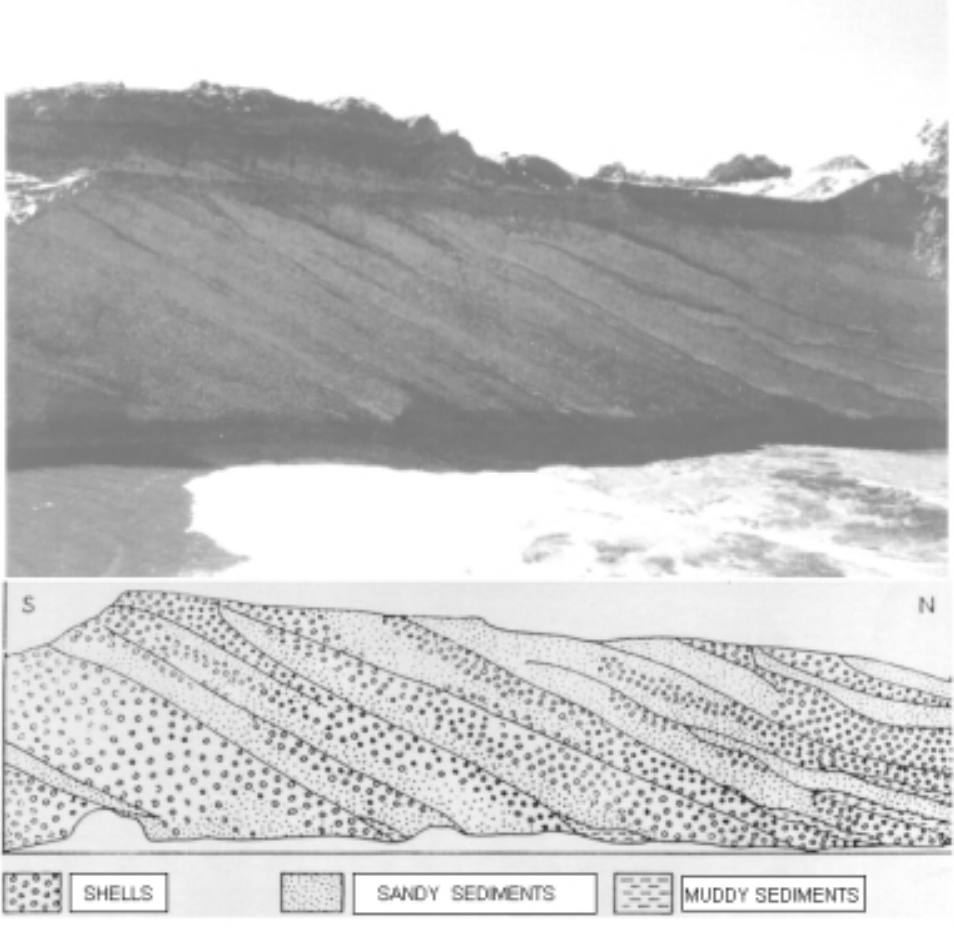
Fig. 9 – Geologic profile of Nova Brasília calcareous shell deposit along the paleocurrent direction, with a sequence of beds showing avalanching processes on the frontal surface.